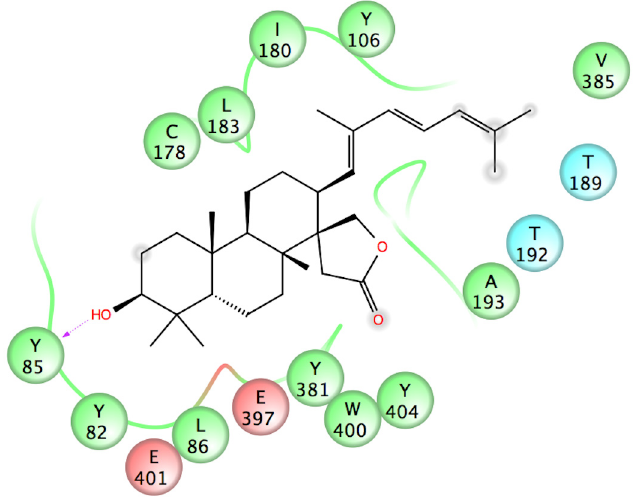
Fig 5. 2-D interaction map of ebelin lactone in complex with the M 1 mAChR model. Negatively-charged, polar and hydrophobic residues are depicted with red, light blue and green circles, respectively. The hydrogen bond between the OH group at position-3 and Y85 residue is indicated by a purple dashed arrow. Ebelin lactone established non-polar interactions with L183, Y82 and L86 (non-conserved residues) which are postulated to be responsible for the allosteric subtype selectivity in muscarinic receptors.